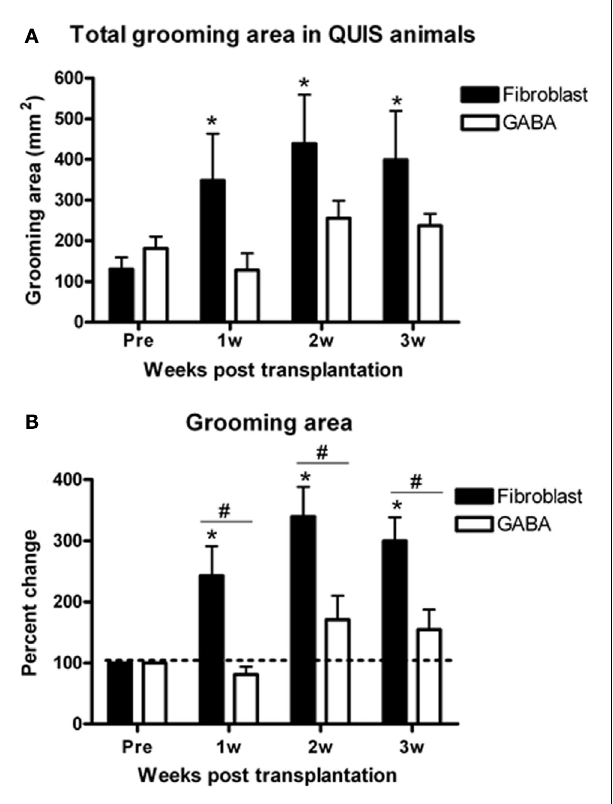
FIGURE 6 | Percent change of the overgrooming area from pretransplantation for GABA and fibroblast-transplanted rats. Control animals displayed significant increases in total overgrooming area (A) and percent change of overgrooming area (B) post-transplantation vs. pretransplantation and also compared to GABA-transplanted animals. GABA-transplanted rats did not display statistically significant changes in either total or percent change of overgrooming compared to pretransplantation. * p < 0.05 vs. pretransplantation, # p < 0.05 vs. GABA